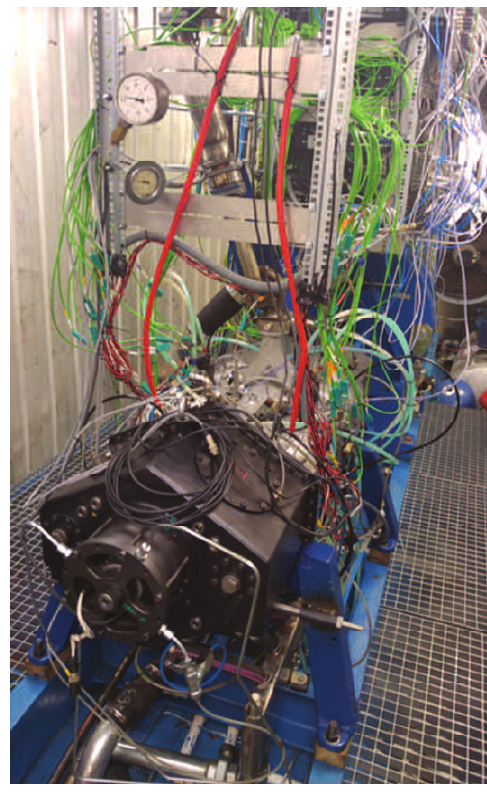
Fig. 3. PAMAR-4 on the test